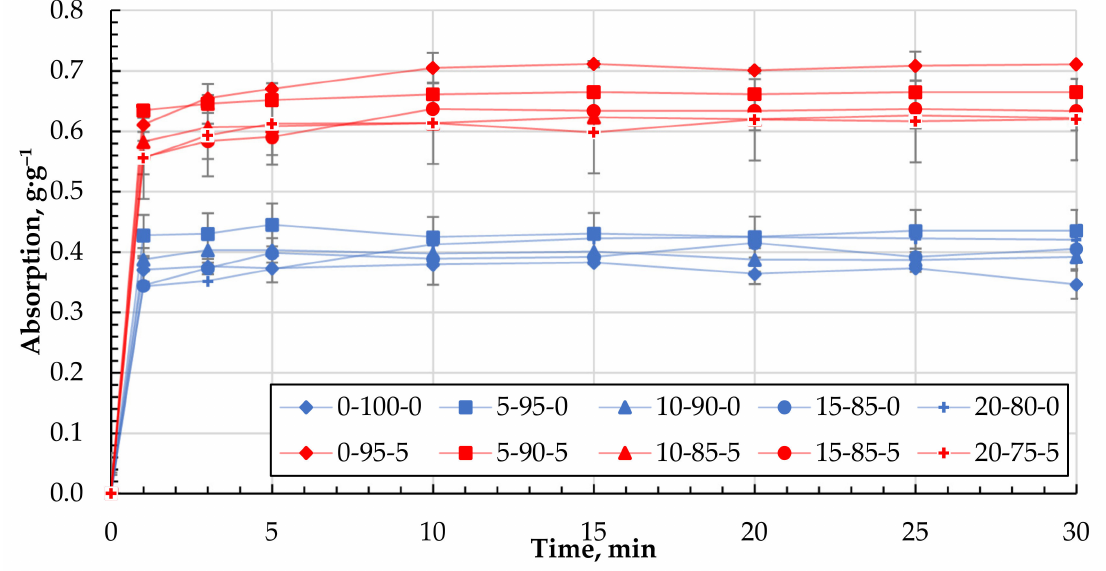
Figure 10. Absorption kinetics of MO for granules with 0 and 5 wt.% of